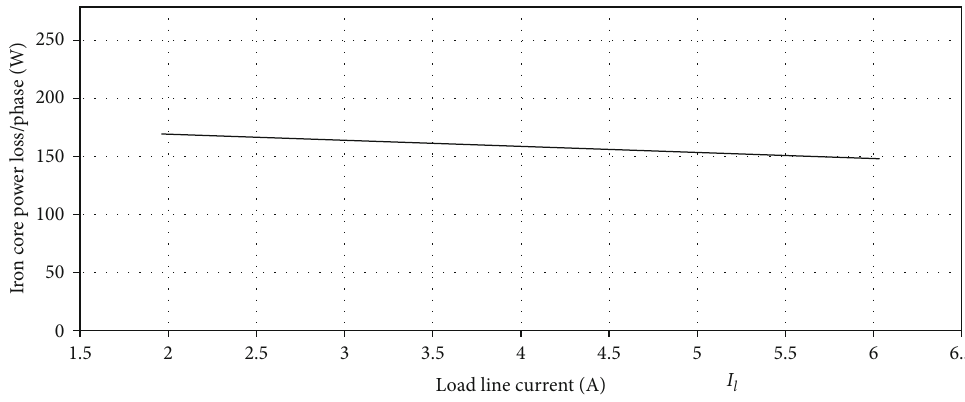
Figure 7: Variation of load current with iron core power loss.